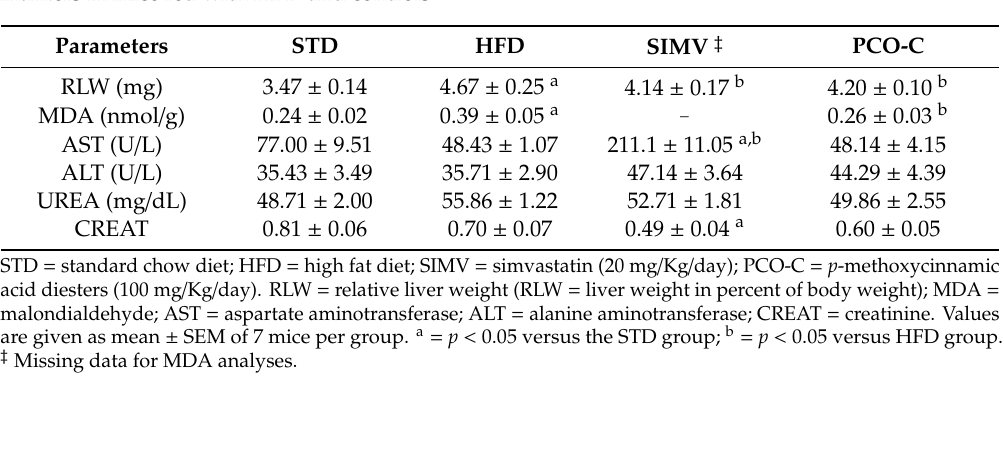
Table 7. E ff ects of PCO-C on the relative liver weight, malondialdehyde and kidney and hepatic toxicity markers in mice fed with HFD and